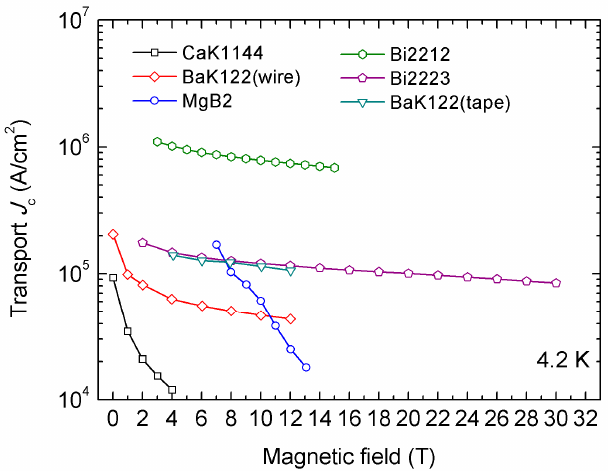
Figure 18. Transport J c of overpressured Bi-2212 [29] and Bi-2223 [65] wires and HIP-processed MgB 2 [42], (Ba,K)Fe 2 As 2 [58,59], and CaKFe 4 As 4 [62] wires and tapes.